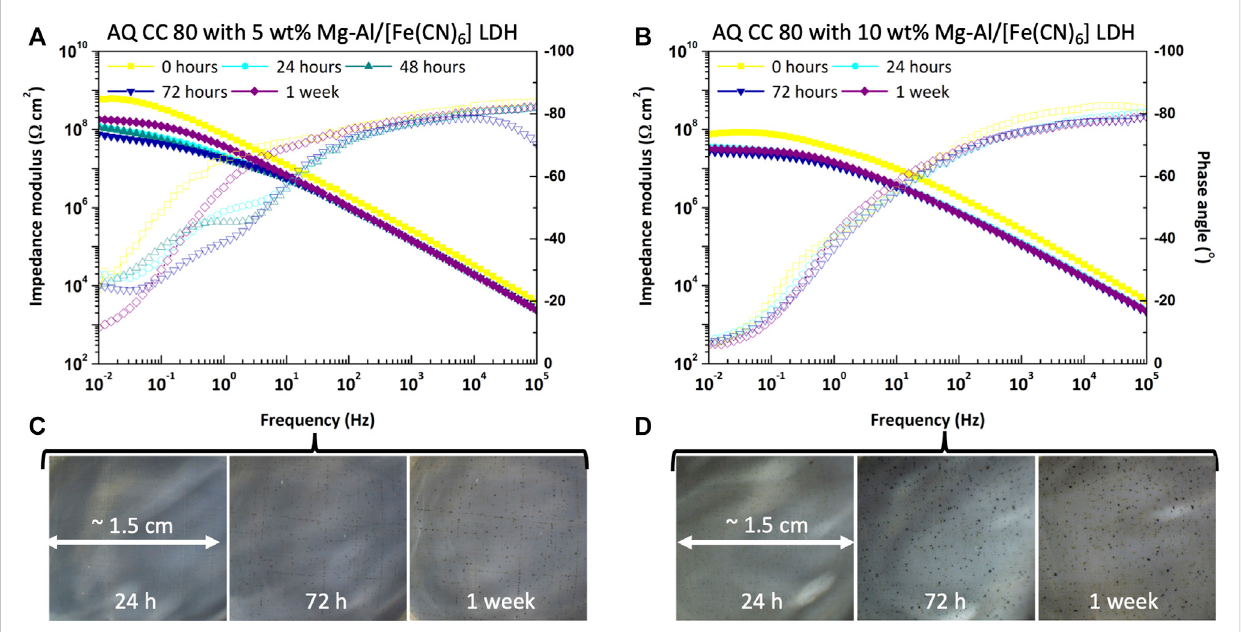
FIGURE 6 Study of corrosion of carbon steel plates coated with acrylic polyurethane AQ CC 80 coating with 5 wt% Mg-Al/[Fe(CN) 6 ] LDH nanoadditive (A, C) and acrylic polyurethane AQ CC 80 coating with 10 wt% Mg-Al/[Fe(CN) 6 ] LDH nanoadditive (B, D) immersed in 0.6 M NaCl during 1 week: EIS plots (A, B) and visual analysis (C, D) .